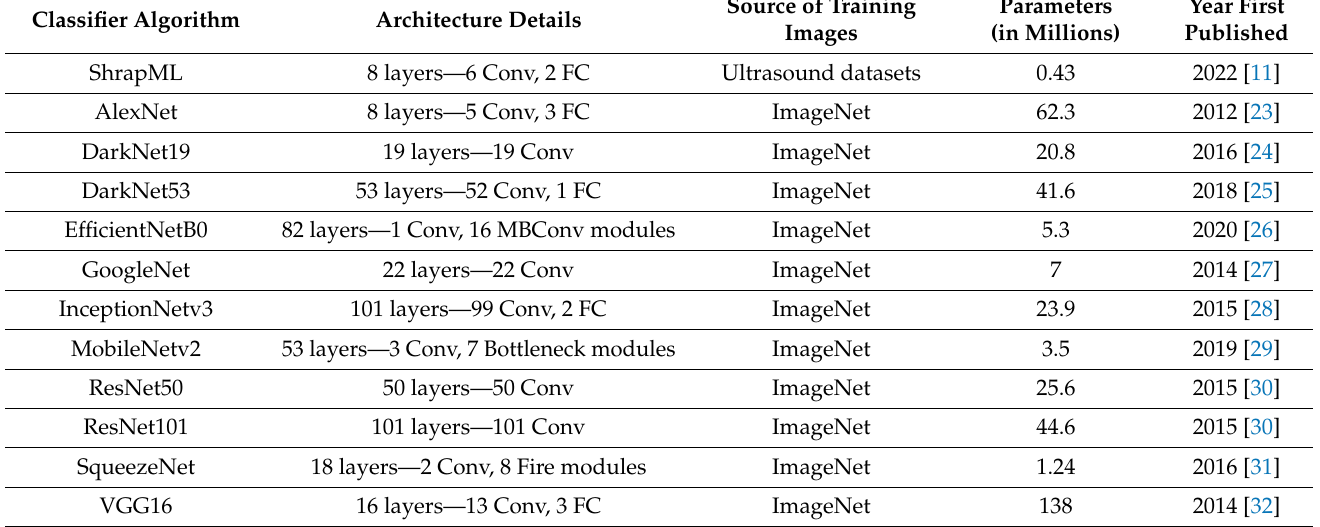
Table 2. Summary of image classifier model architecture for shrapnel identification in ultrasound image datasets. The algorithm architecture details identify the layer counts as layers with weights: Conv layers and fully connected (FC) or dense layers. This column also contains information about various modules in use (Fire, MBConv, Bottleneck,